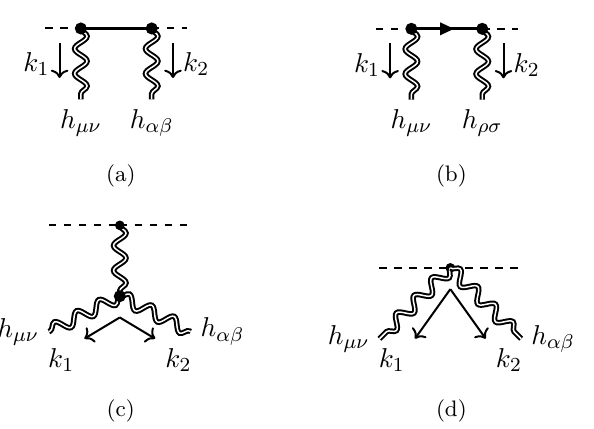
Figure 4. Worldline diagrams contributing to the on-shell Compton amplitude. 4a, 4b, with crossed topologies are associated with fluctuations of kinematic and spin variables,